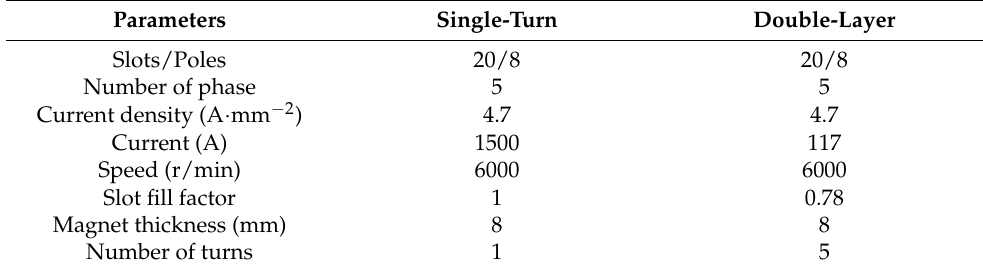
Table 3. Main specifications for load